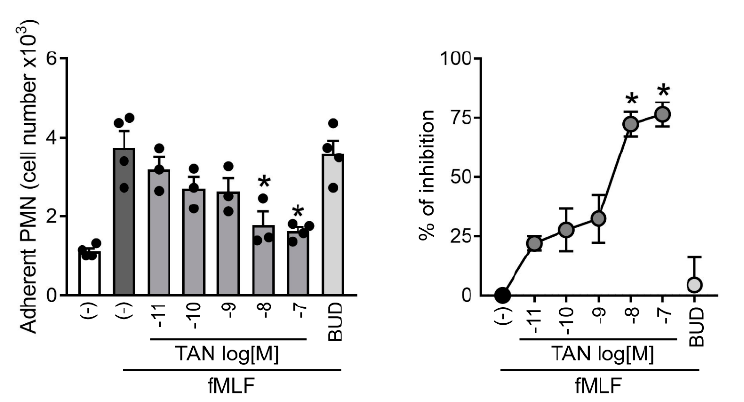
Figure 1. Tanimilast reduces neutrophil adherence to HUVEC monolayers. Human neutrophils, previously stained with CFSE, were incubated with the indicated concentrations of tanimilast (TAN), budesonide at 10 − 7 M (BUD), or vehicle ( − ), and then added to HUVEC monolayers in the absence or in the presence of fMLF 10 − 6 M. Neutrophil adhesion was assessed by counting neutrophils that remained associated to HUVEC after extensive washings, and were subsequently detached by trypsin-EDTA incubation. The left panel shows absolute cell numbers, while the right panel depicts the percentage of inhibition by tanimilast and budesonide of the neutrophil adherence found in fMLF-activated neutrophils. Dots represent the result of individual donors. * p < 0.05 One-way ANOVA followed by post-hoc test or one-sample t -test ( n = 3–4). Table 1. Inhibitory potency of tanimilast on different neutrophil functions.